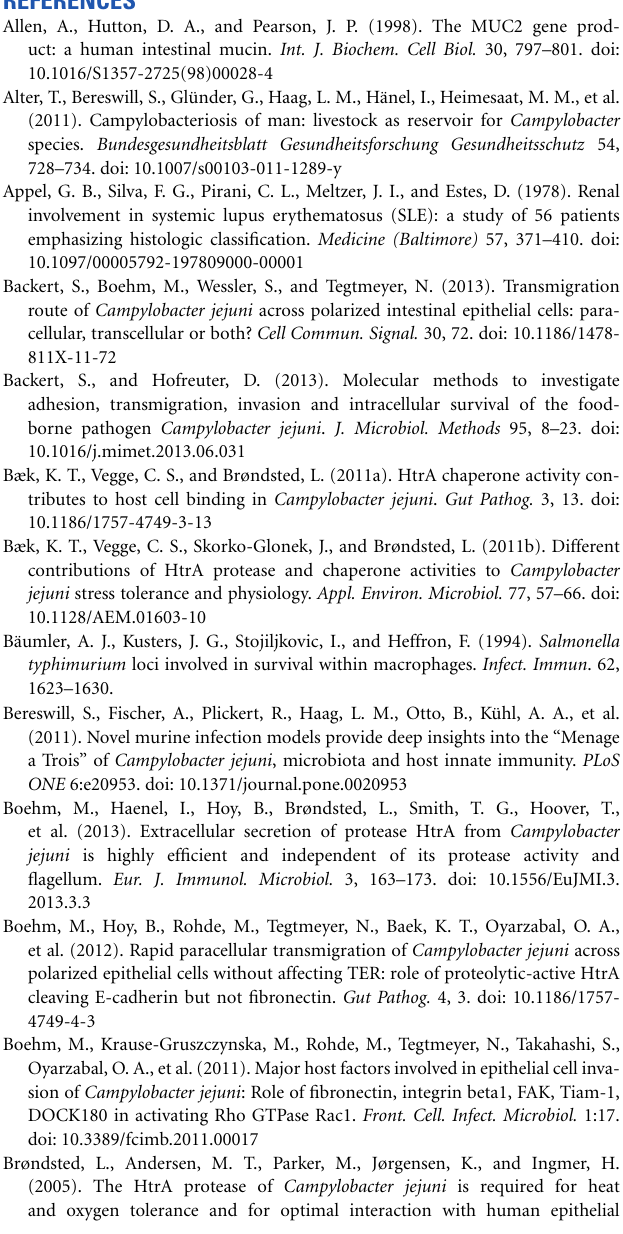
(B) Analysis of protease activities in all three indicated strains by casein zymography. The position of proteolytically active multimeric HtrA proteins is indicated with arrows. Figure S2 | Effect of high temperature and oxygen concentration on growth of the C. jejuni (cid:2) htrA mutant and genetically complemented htrA strain. Serial dilutions (10 − 1 , 10 − 2 , 10 − 3 , 10 − 4 , 10 − 5 , and 10 − 6 ) of the indicated C. jejuni strains [NCTC11168 wild-type (WT), NCTC11168 (cid:2) htrA and complemented NCTC11168 (cid:2) htrA/htrA ] with an OD 600 of 0.1 were spotted in 10 μ l volumes onto Müller-Hinton agar plates. The plates were incubated for 3 days in jars under microaerobic conditions at (A) 42 ◦ C, (B) 44 ◦ C, or (C) 42 ◦ C in the presence of 18% O 2 . Representative sections of the agar plates from three independent experiments are